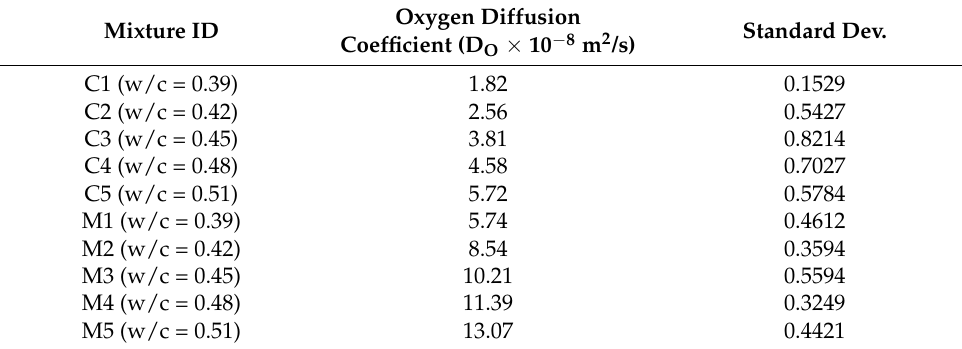
Table 4. Oxygen diffusion coefficient results of all mixtures.